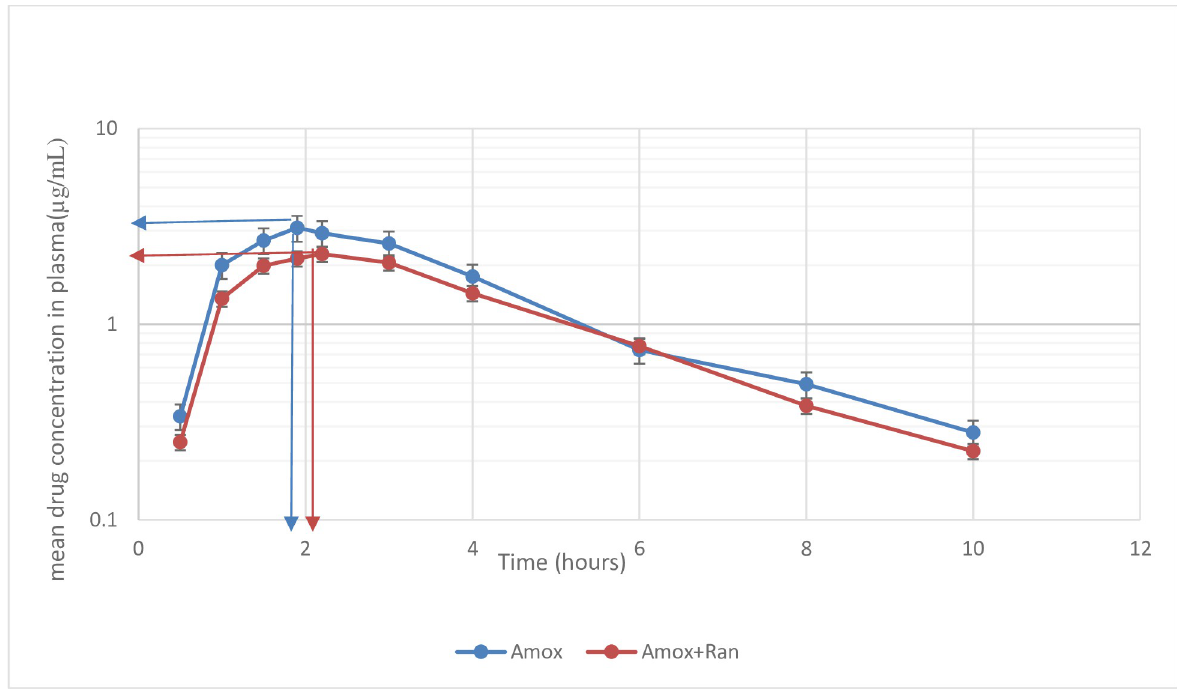
Fig 1. Mean plasma concentration of amoxicillin alone and amoxicillin with